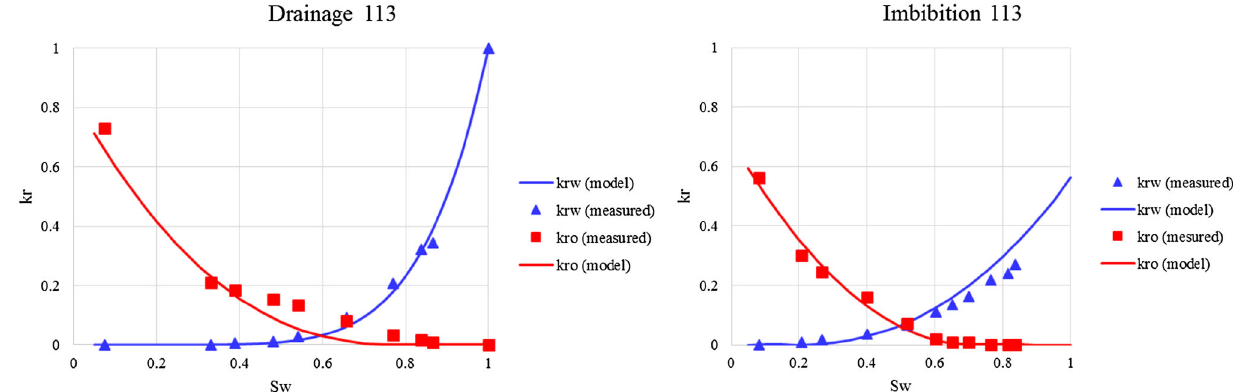
Fig. 10 Drainage and imbibition K r correlation for sample plug #113